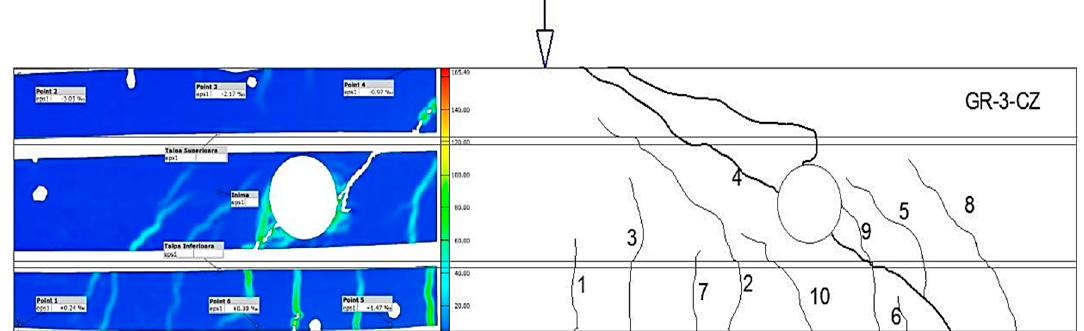
Figure 12. Cracking pattern at ultimate load for the fly ash beam (GR-3-CZ).